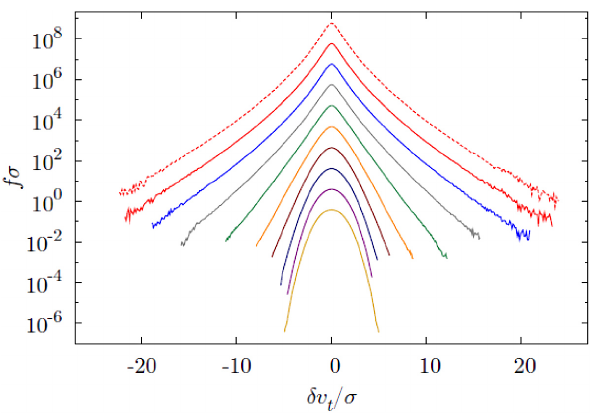
Fig. 1. PDF of velocity increments as a function of the lag length | l | , from small (top) to large scales (bottom) (extracted from Wilczek, 2010). The non-Gaussianity is clear for velocity increments at small